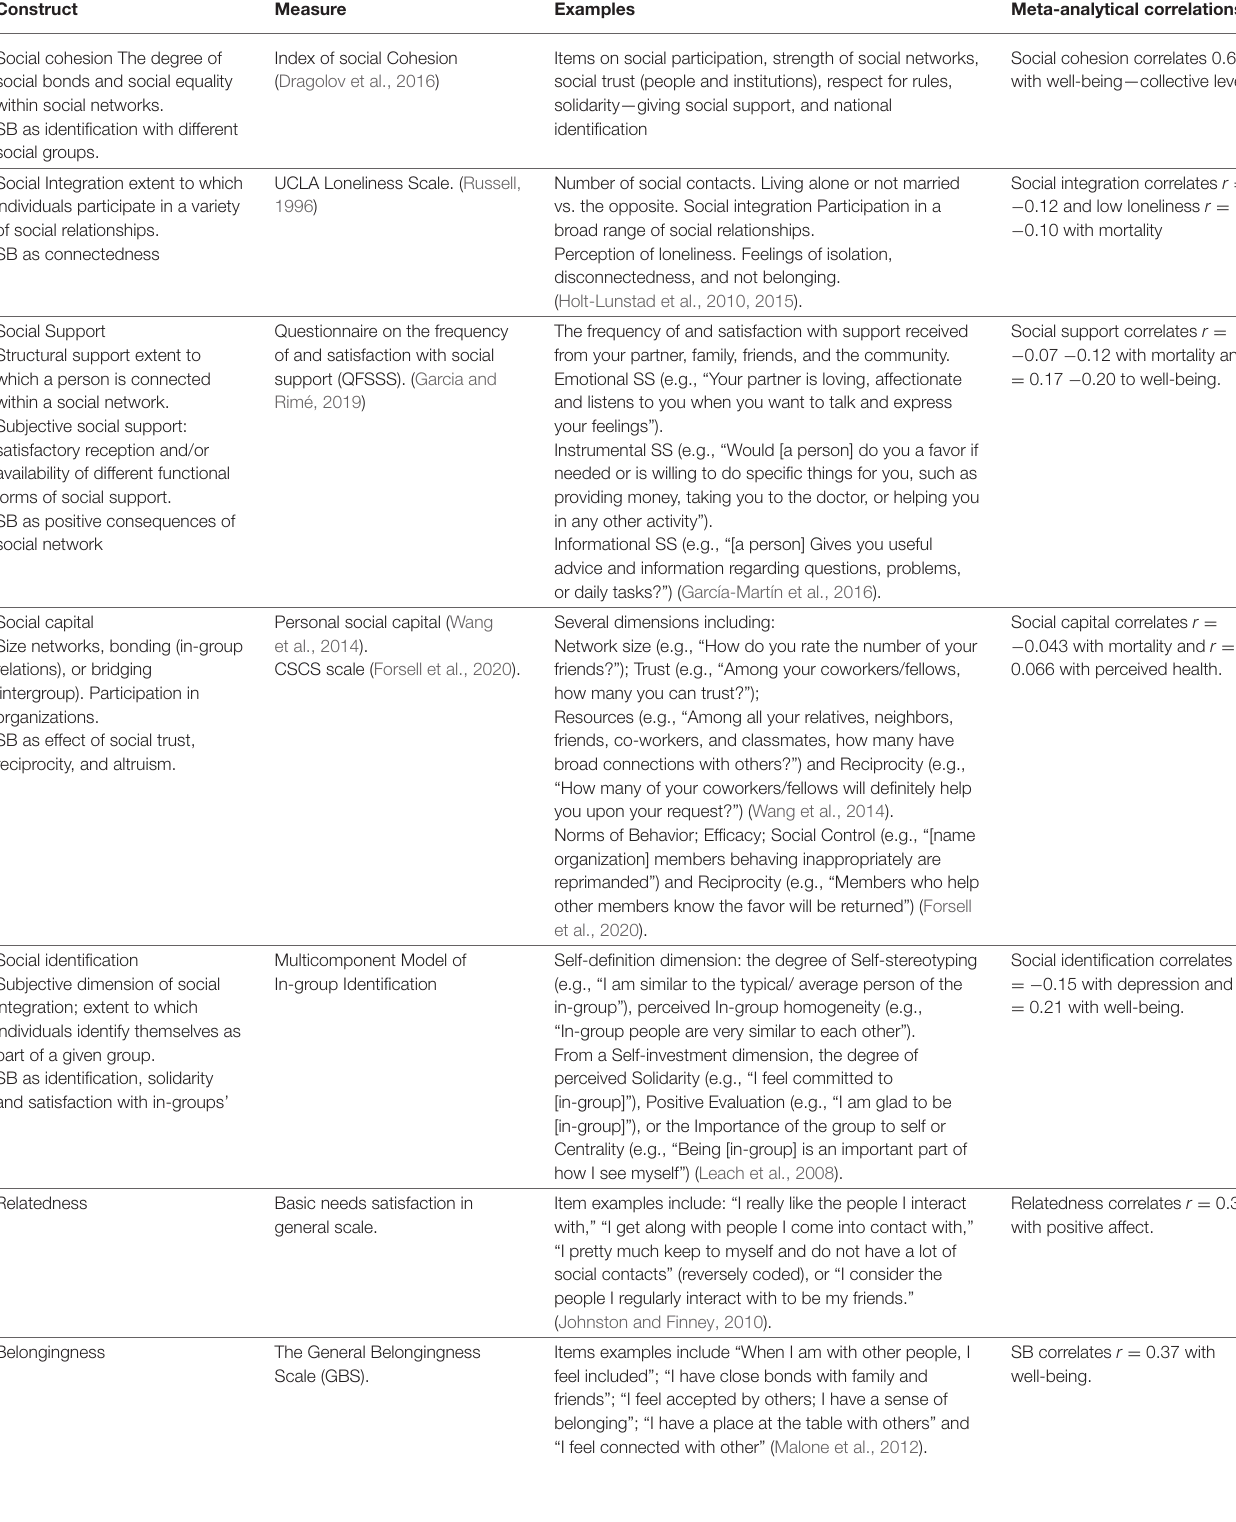
TABLE 2 | Constructs and measures related to Social Belongingness